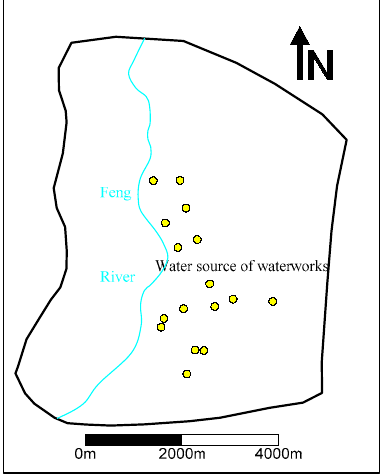
Figure 6. Positions of the river and wells.